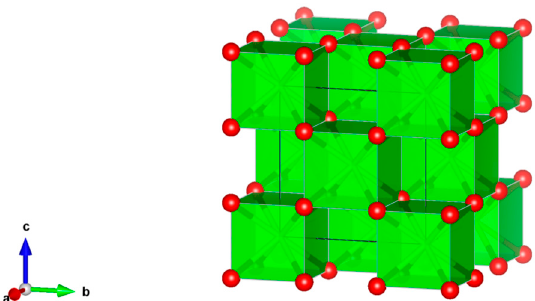
Figure 2. Fluorite, ZrO 2 . Structure cubic, Sp. gr. Fm3m. Cations can be Zr, Hf, Th, U, Np and Pu.